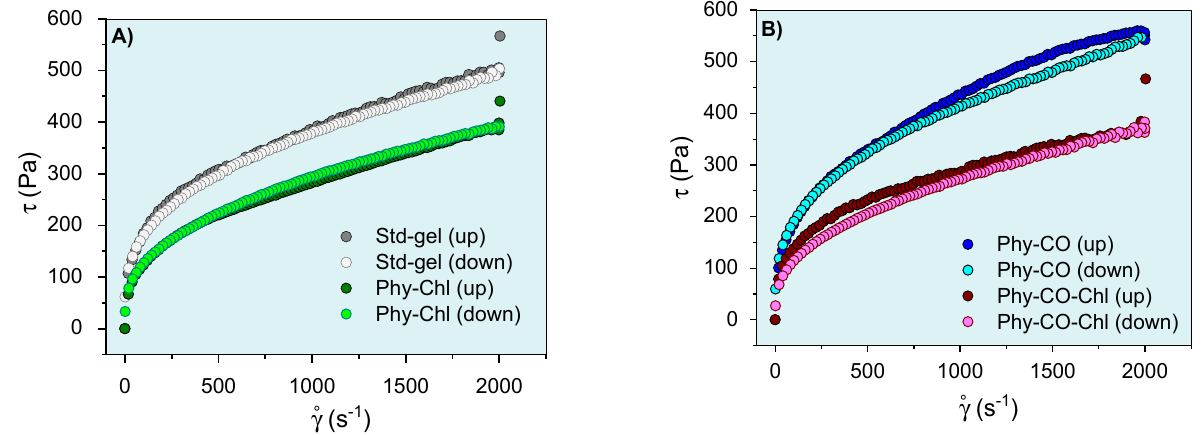
Figure 7. Phy-gels continuous flow rheograms at 32.0 °C ( A , B ). Standard deviations were omitted for clarity; however, the coefficient of variation of the replicate analyzes was <10% in all cases.